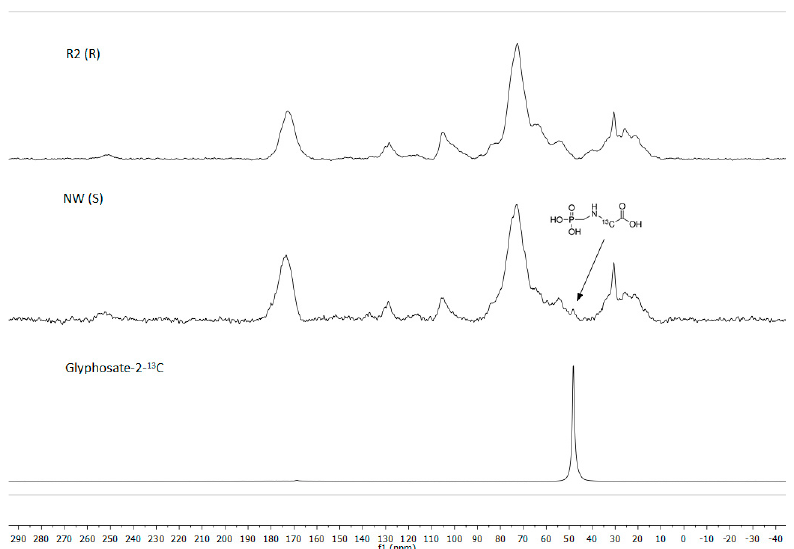
Figure 5. The 13 C NMR spectra obtained from untreated NW (S)/R2 (R) biotypes plantago ( Plantago lanceolata L.) dried leaf tissue, 48 h after glyphosate application on the treated leaves. Arrow indicates glyphosate signal at approximately 50 ppm identical to the glyphosate-2- 13 C (99% atom) standard’s chemical shift.